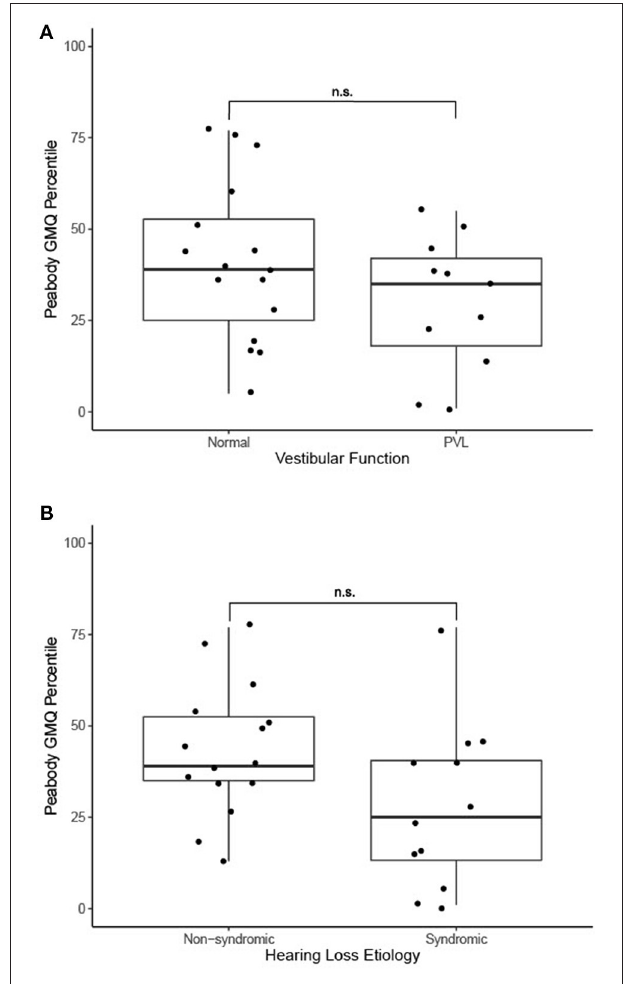
FIGURE 1 | (A) Motor function outcomes in 27 patients with PVL and with normal vestibular function, n.s., no statistically significant difference (independent samples t -test). (B) Motor function outcomes in 27 patients with genetic non-syndromic and syndromic forms of hearing loss, n.s., no statistically significant difference (independent samples t